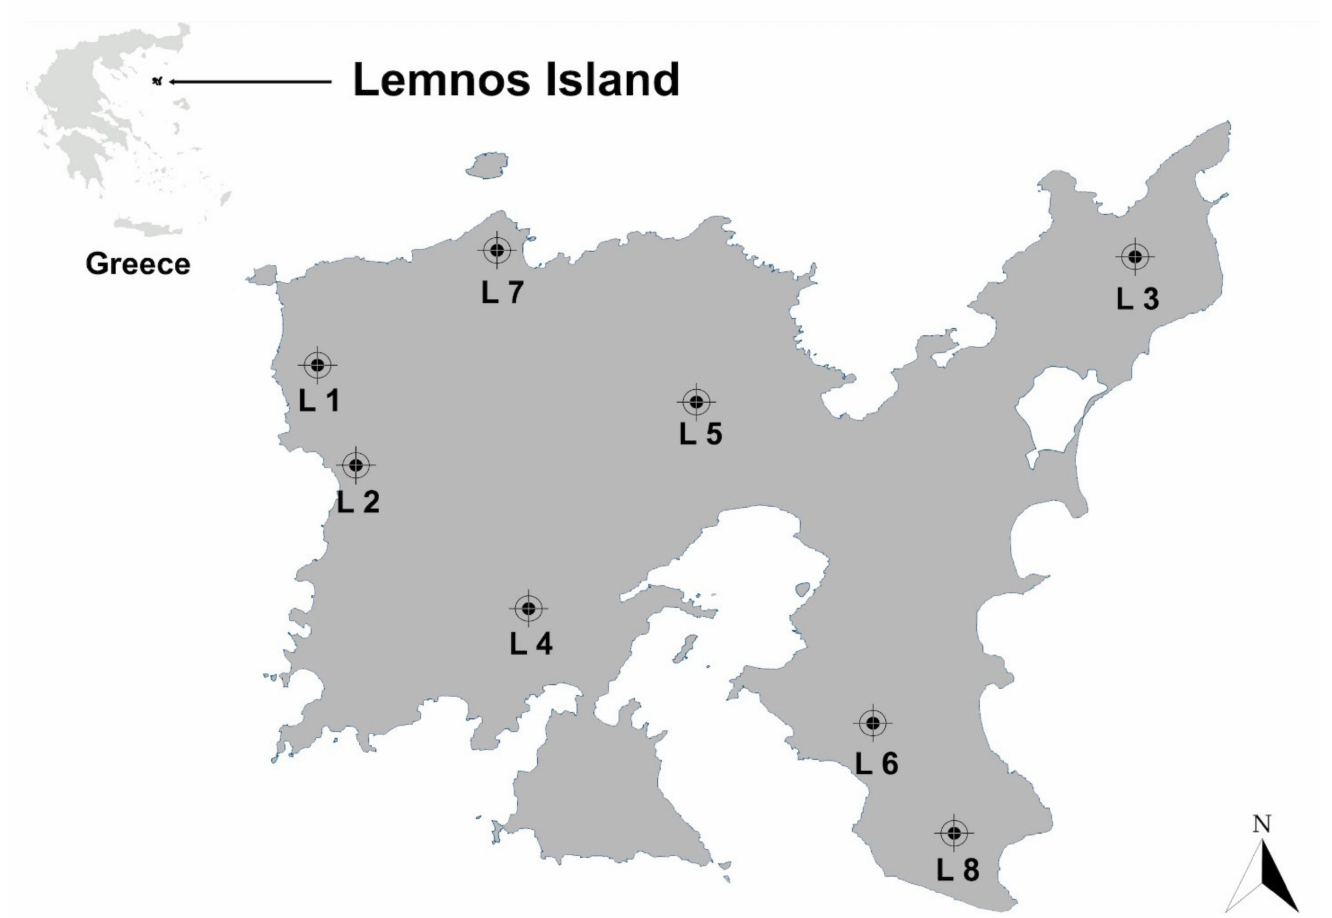
Figure 1. Lemnos island (north-eastern Aegean Sea) from where the eight different honey samples studied in this work were collected. L1–L8: Sampling